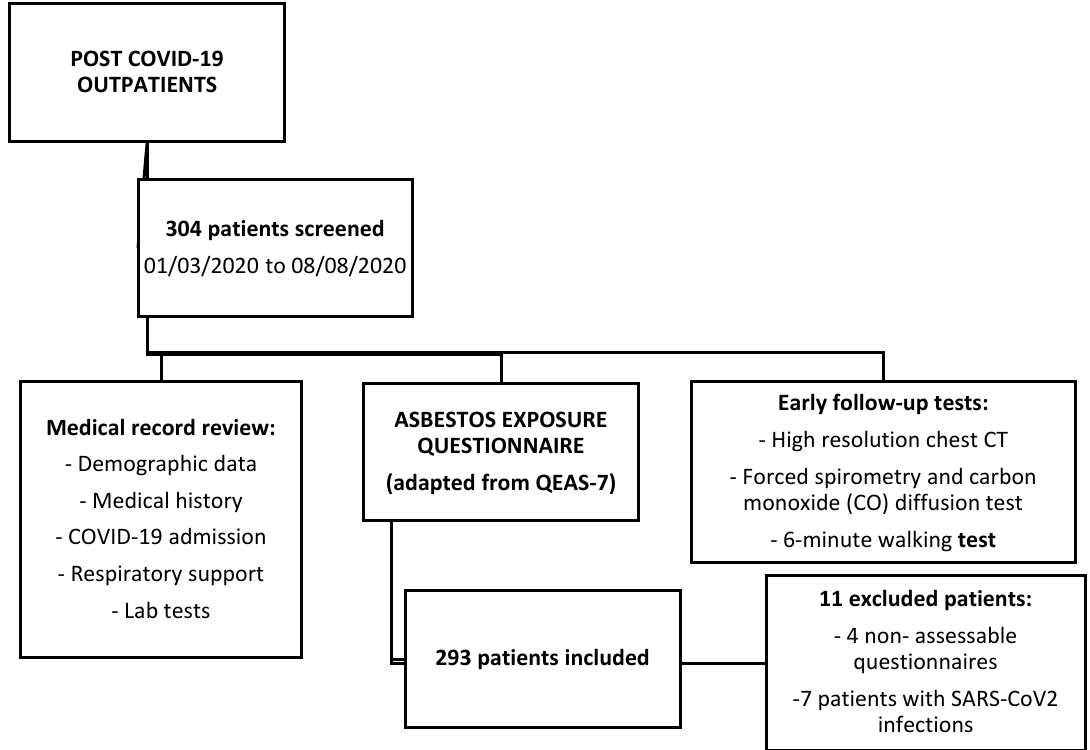
Figure 1. Flow chart of the patients recruited for the